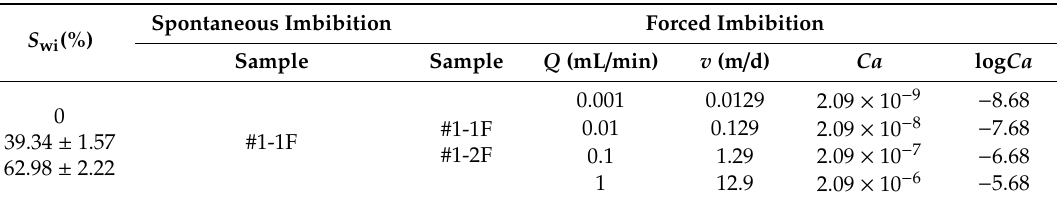
Table 3. Experimental conditions in spontaneous imbibition and forced imbibition